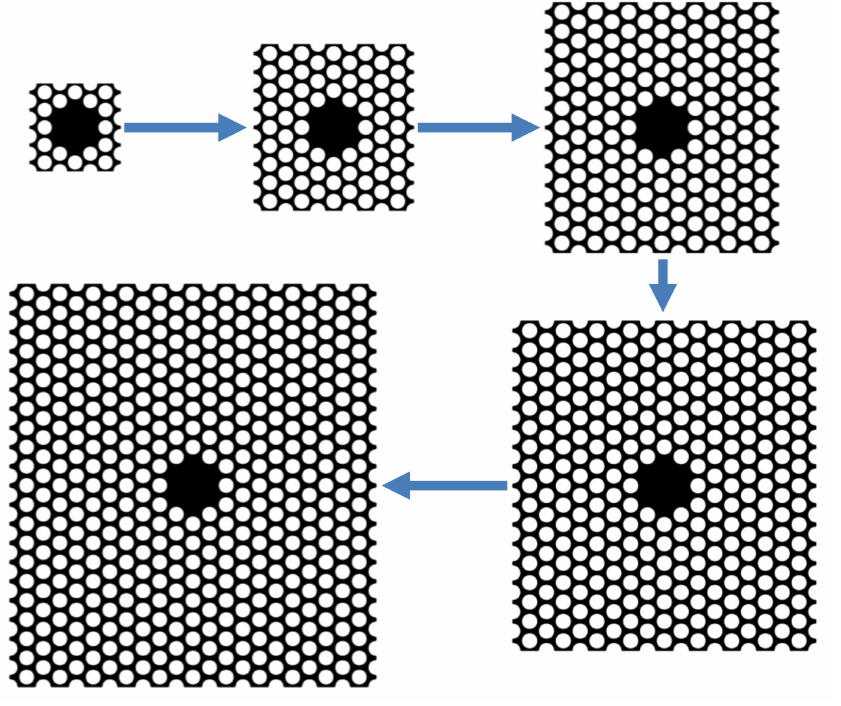
Figure 9. Start from the primitive 3 × 5-cell structure with central defect, constantly adding cells to the periphery, changing the structure composition into 5 × 9, 7 × 13, 9 × 17, 11 × 21 cells along the direction of the blue arrow.